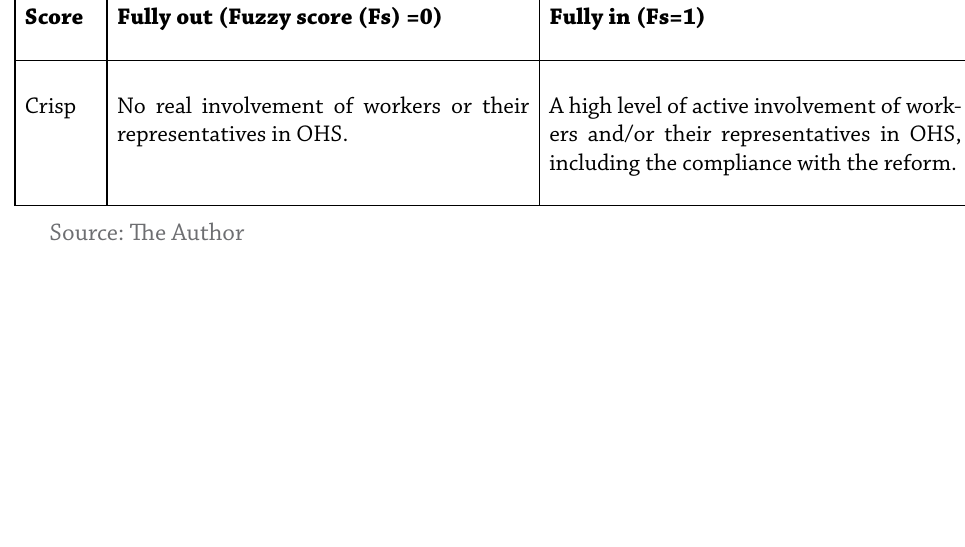
Table 2: Calibration of worker participation Score Fully out (Fuzzy score (Fs) =0) Fully in (Fs=1)